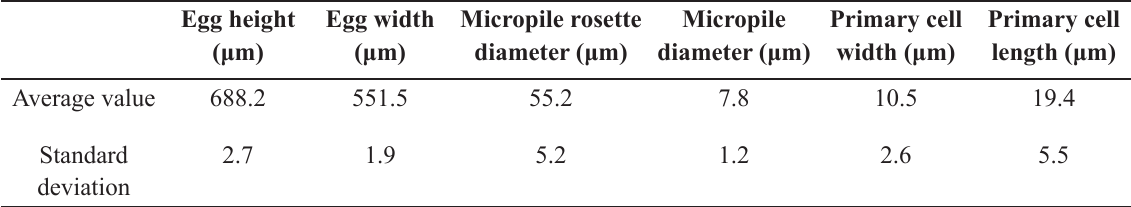
Table 2. Measurements of the egg of M. timandra timandra Coutsis & van Oorschot,